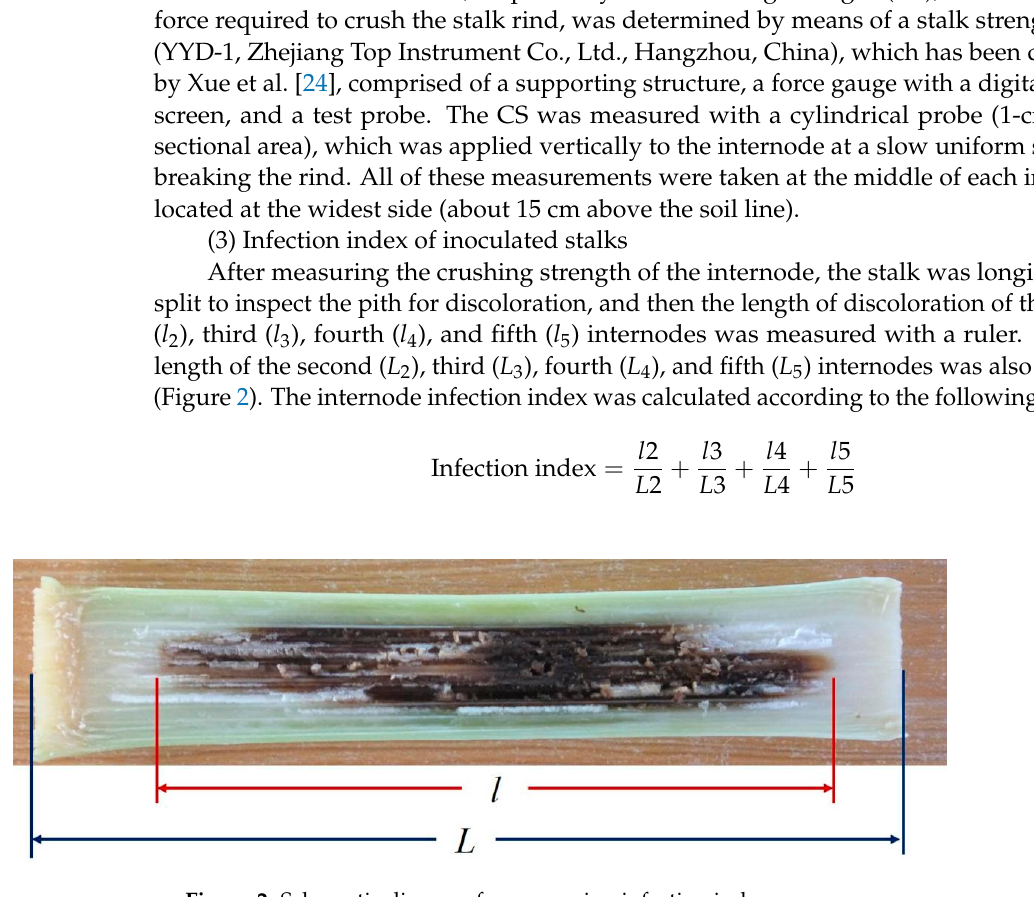
Figure 2. Schematic diagram for measuring infection